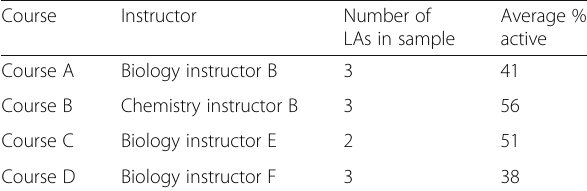
Table 3 Details for the 4 sample courses